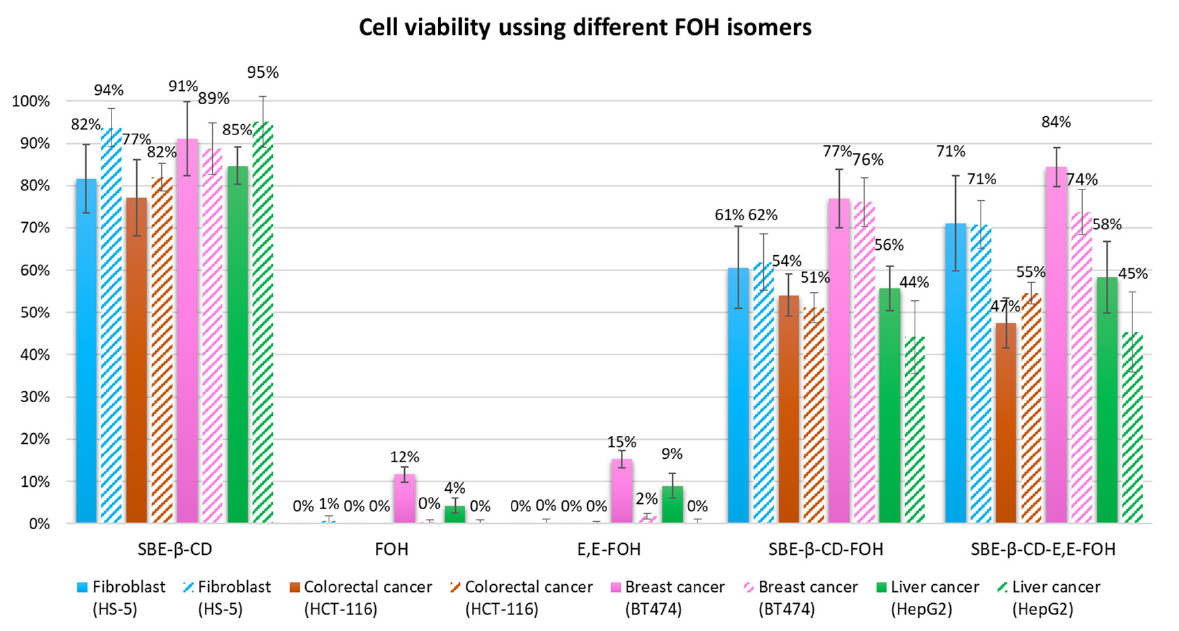
Figure 5. Cell viability results of each cell line treated for 24 h (filled columns) and 48 h (hatched columns).